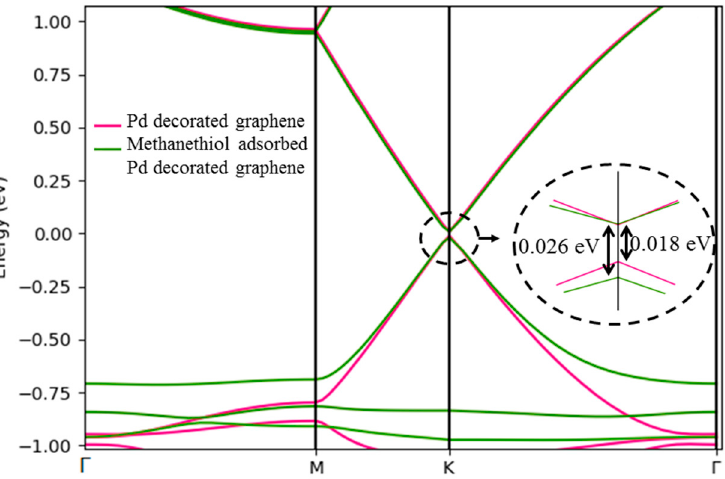
Figure 6. Band structure of Pd-decorated graphene and methanethiol adsorbed Pd-decorated